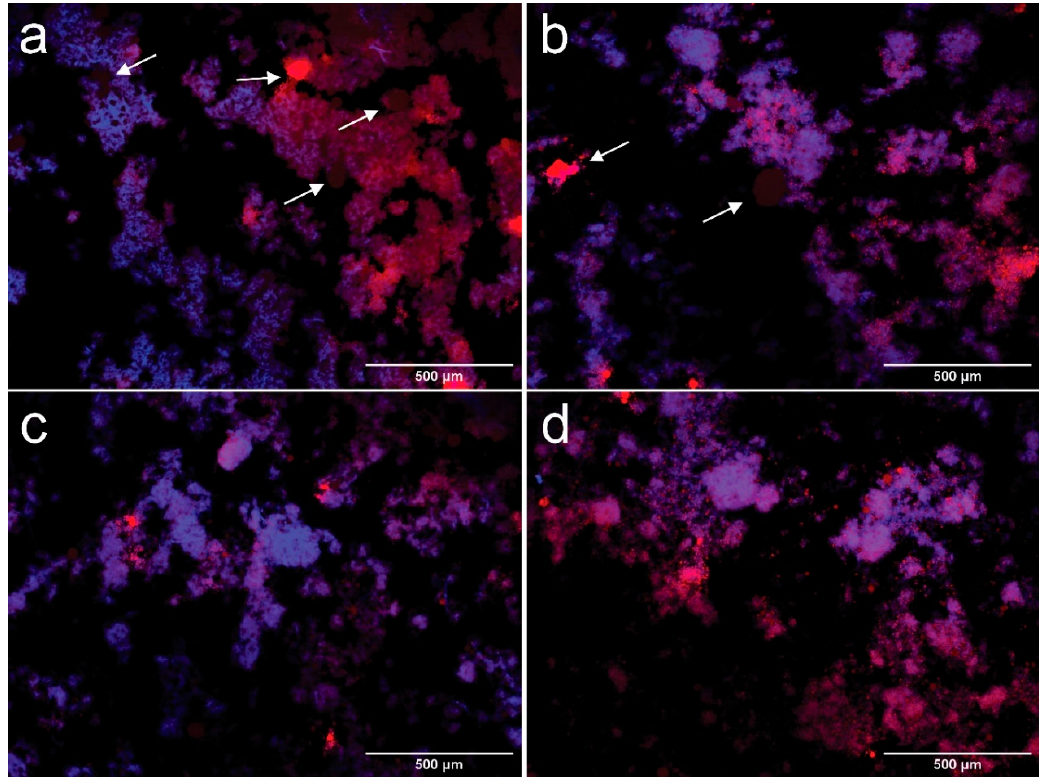
Figure 3. Fluorescence microscopy images taken at 100× of samples CCNFs15 ( a ), CCNFs30 ( b ), CCNFs45 ( c ), CCNFs70 ( d ) after 1 day of their manufacture. CNFs are colored in blue and oil droplets are colored in red. Coalesced oil structures are pointed by arrows in the images.